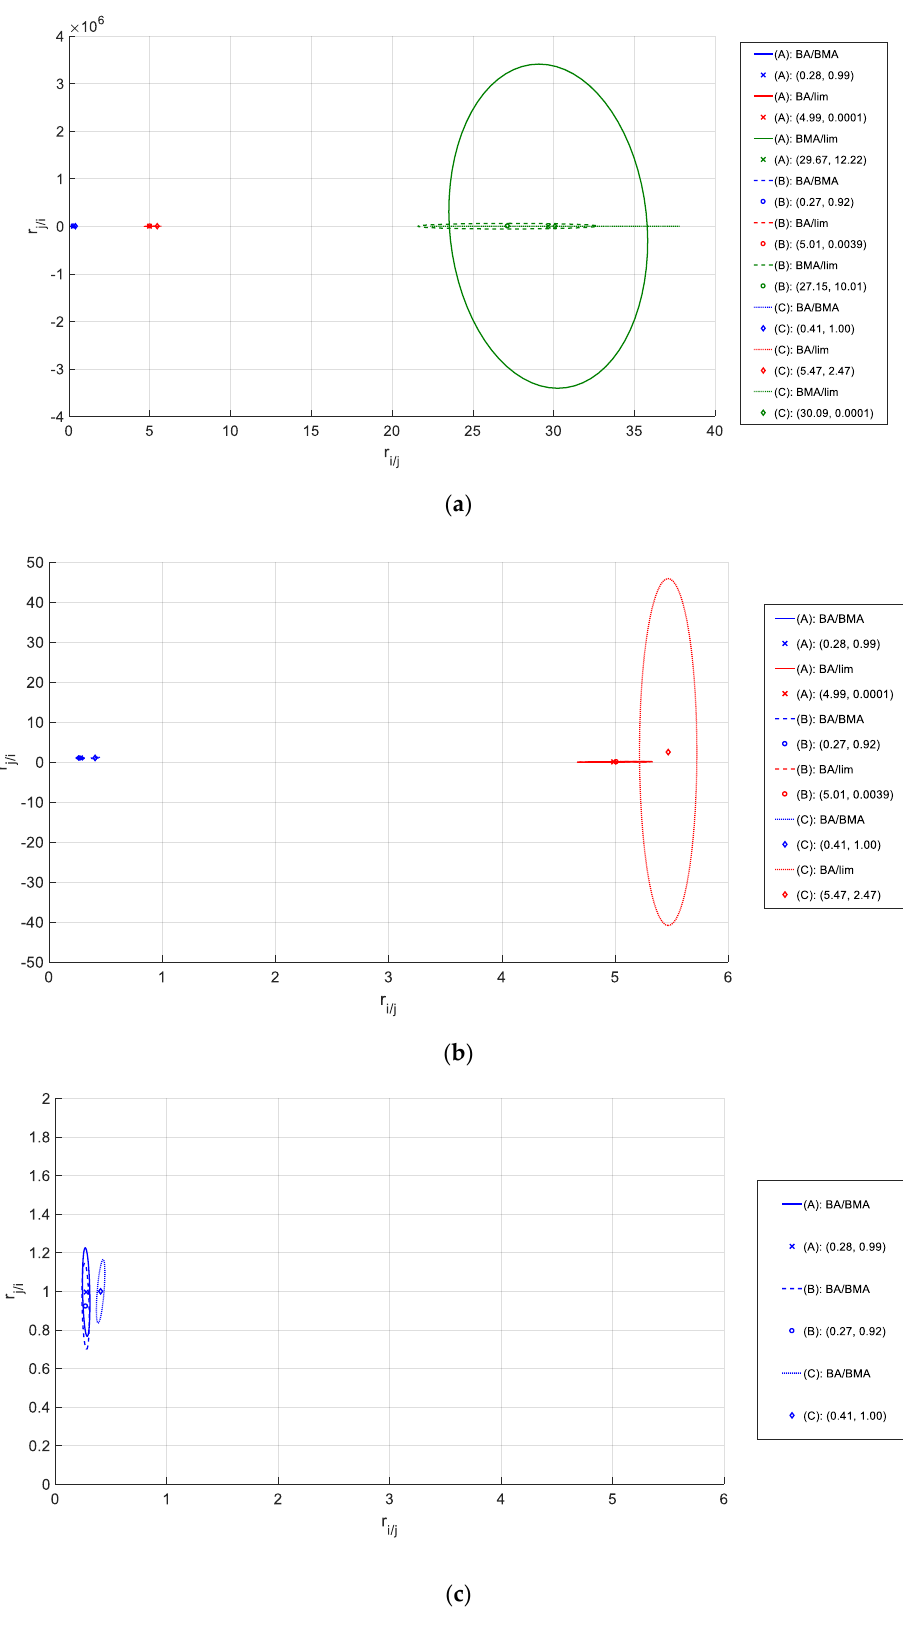
Figure 5. ‘Ternary’ reactivity ratio estimates for the terpolymerization of BA/BMA/lim, with data from Ren et al. [27].